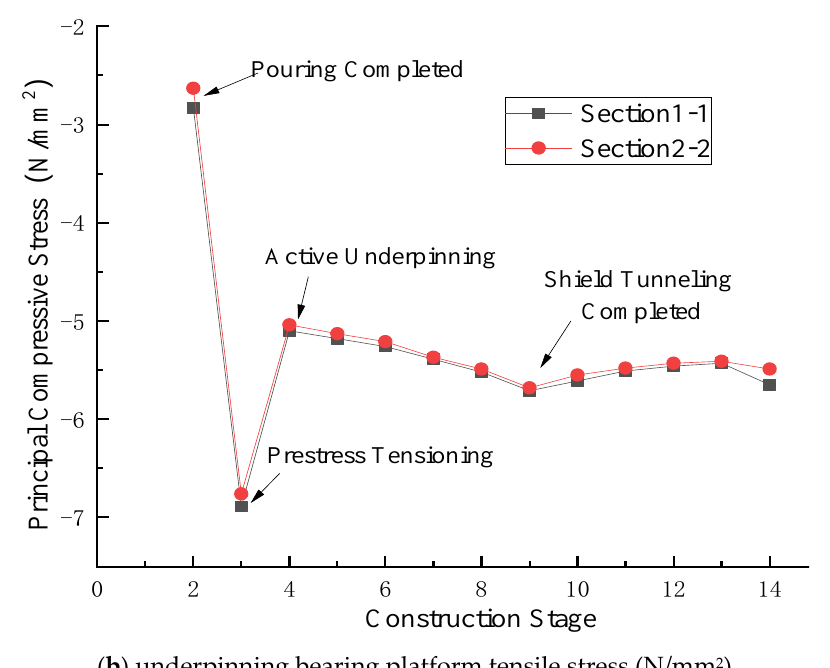
Figure 10. Stress result of the numerical